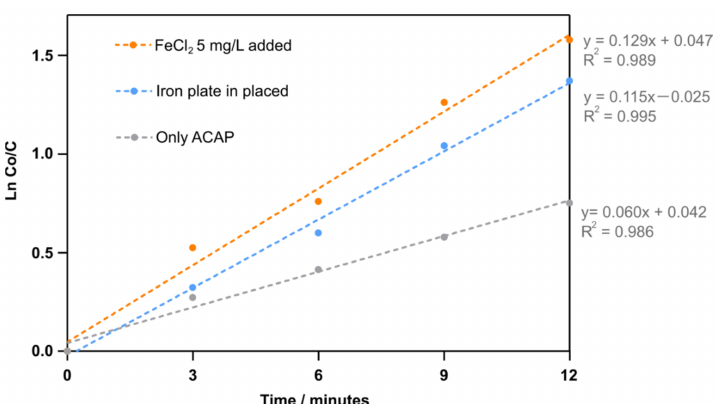
Figure 9. Time variation of dimensionless RhB concentration under different treatment conditions.